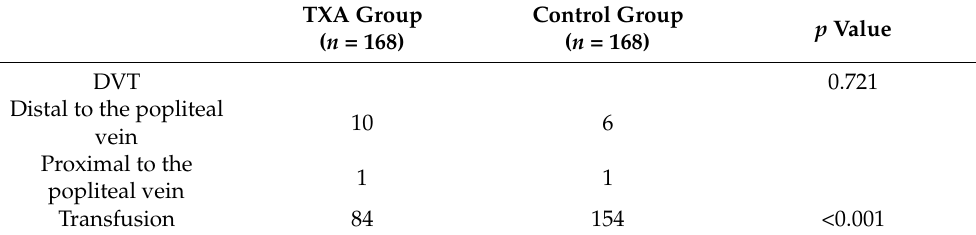
Table 3. Comparison of outcomes between the TXA group and the control